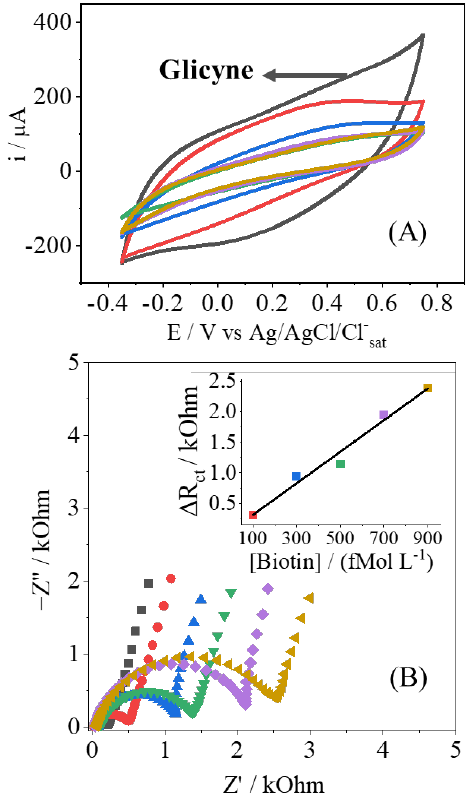
Figure 4. Cyclic voltammetry ( A ) and Nyquist plot ( B ) of the EIS measurement to Biotin detection (100 up to 900 fmol L −1 ) indicated by colors in both CV and EIS. Table 2. Parameters ’ values obtained by EIS to PPy e PPy/AuNPs after fitting, R 2 > 0.98. Glycine